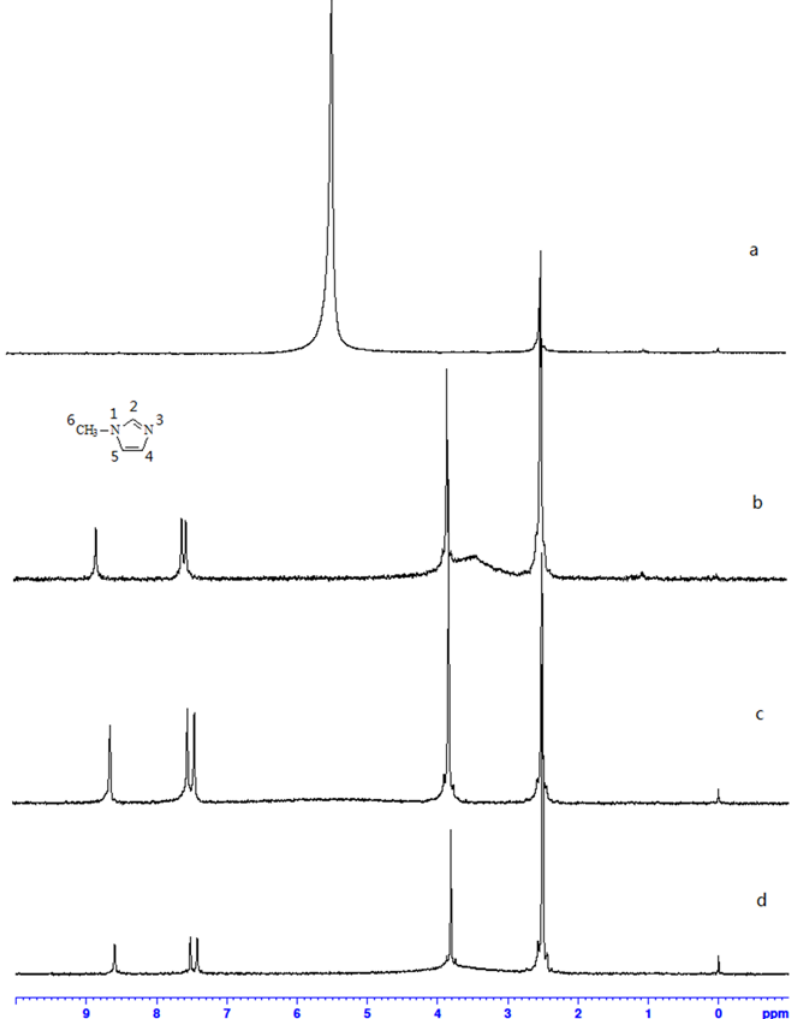
Figure 2. 1 H NMR spectra. ( a ) phosphotungstic acid; ( b ) N -methyl imidazolium